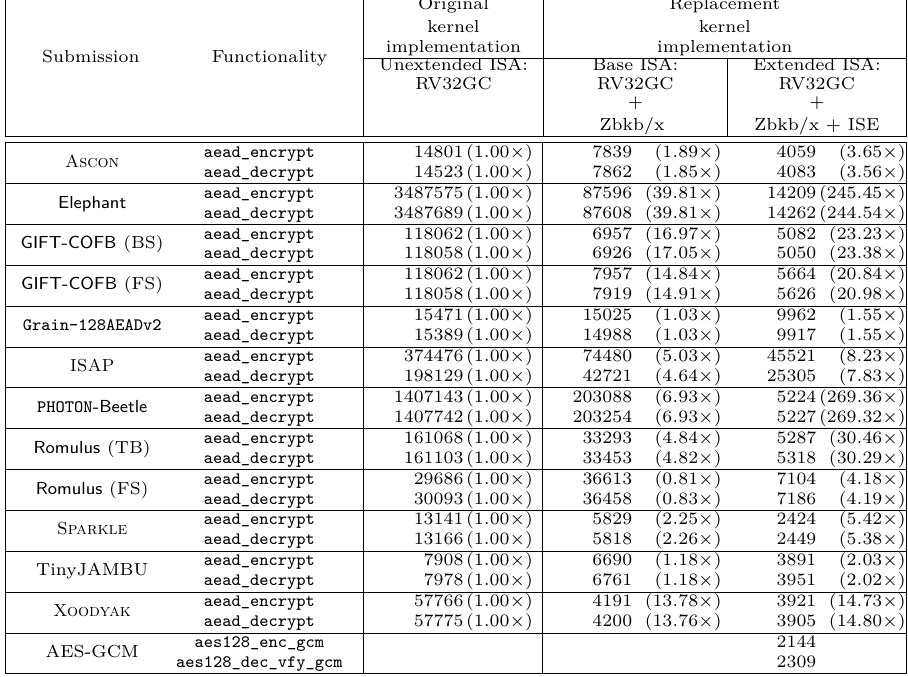
Table 4: Software-oriented evaluation, i.e., utilisation of each ISE design: latency measured in clock cycles (plus increase/decrease factor versus unextended ISA in parentheses) for indirect kernel use via AEAD API (with 16 B plaintext, ciphertext, and associated data).